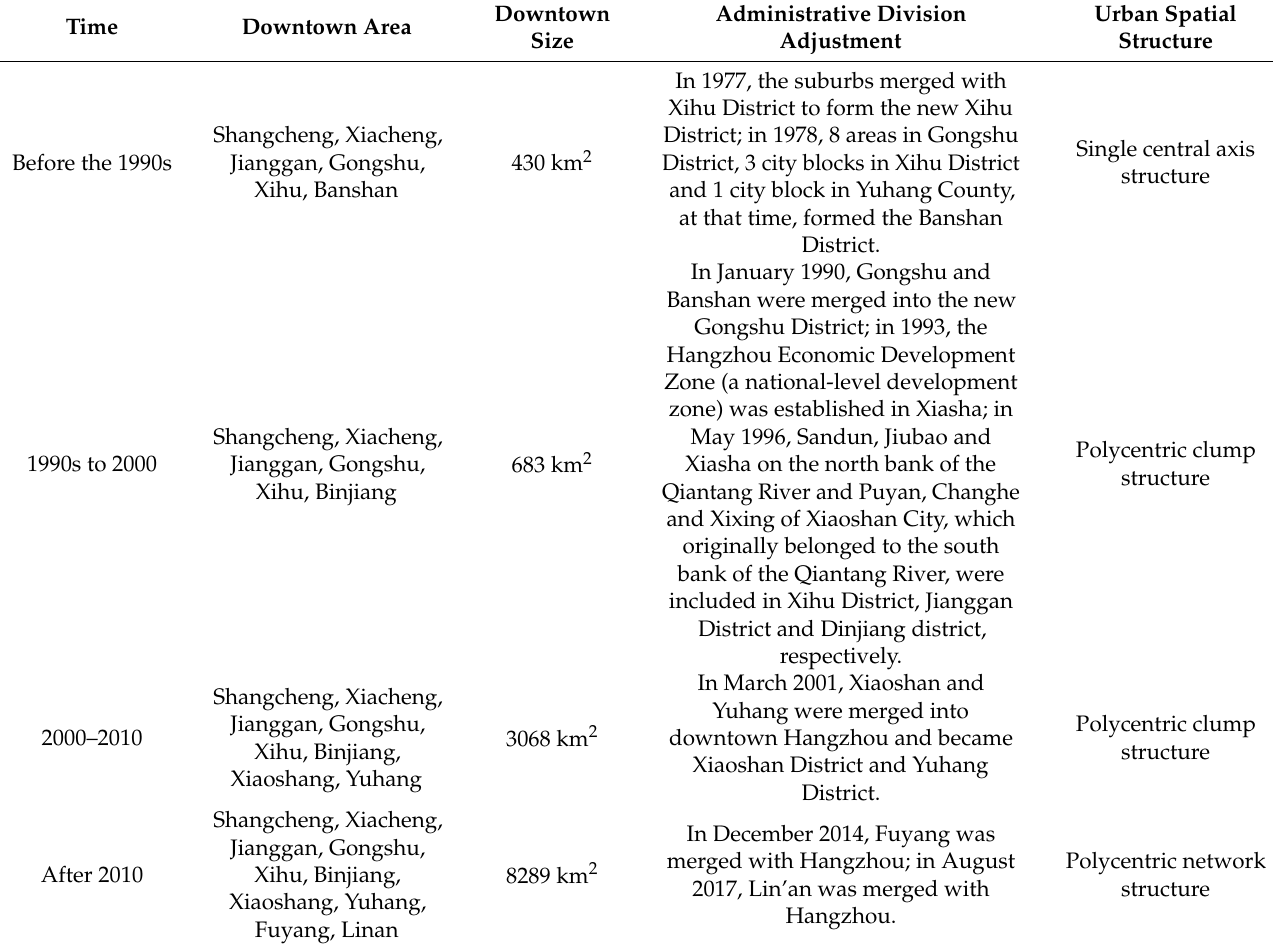
Table 1. Adjustment of administrative districts in